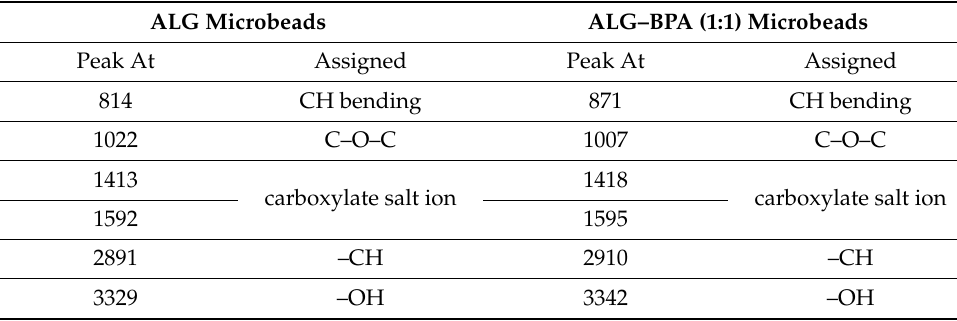
Figure 5. The ATR-FTIR analysis for ALG and ALG–BPA (1:1) microbeads. Table 1. Peak data for ALG and ALG–BPA (1:1) microbeads.